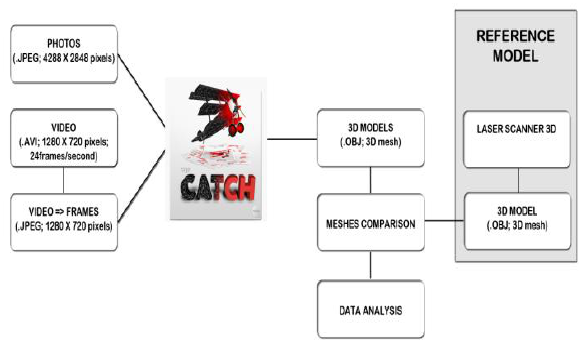
Figure 1. The workflow of the project of